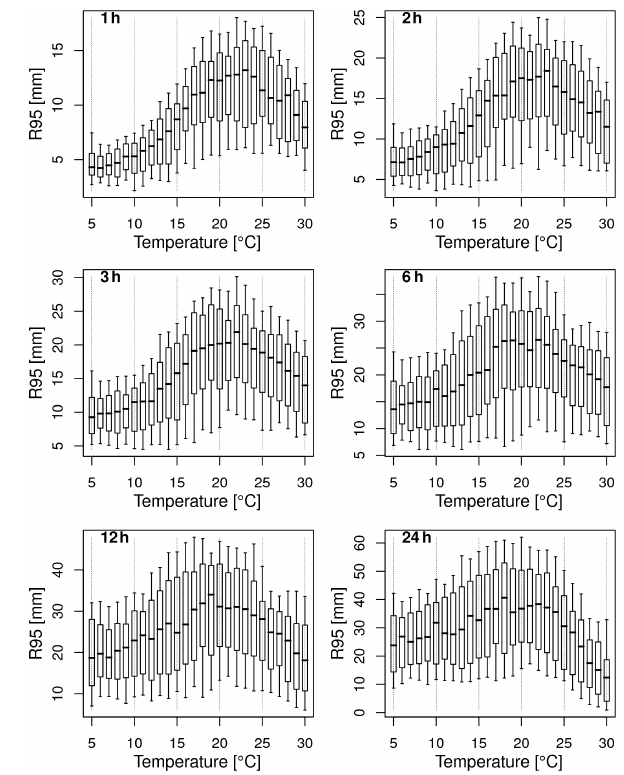
Figure 6. Box plots of 95th rainfall quantile vs. temperature at 1, 2, 3, 6, 12 and 24h aggregation timescales.